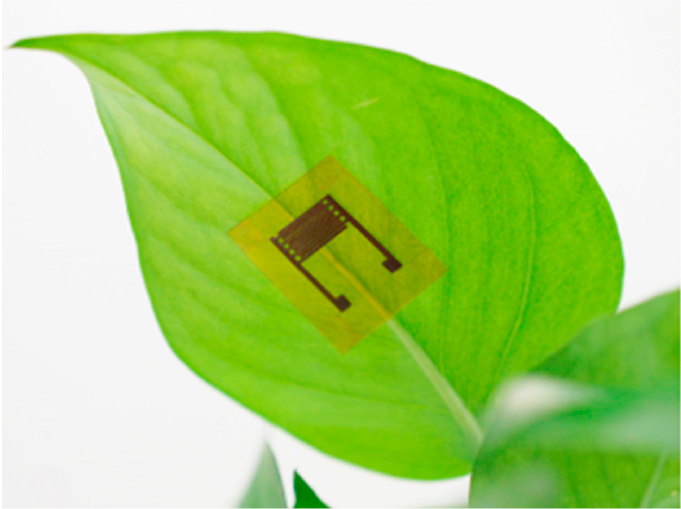
Figure 2. A photograph of the graphene oxide-based humidity sensor attached to the lower surface of a leaf (reproduced from Lan et al. 2020 [157] with permission).